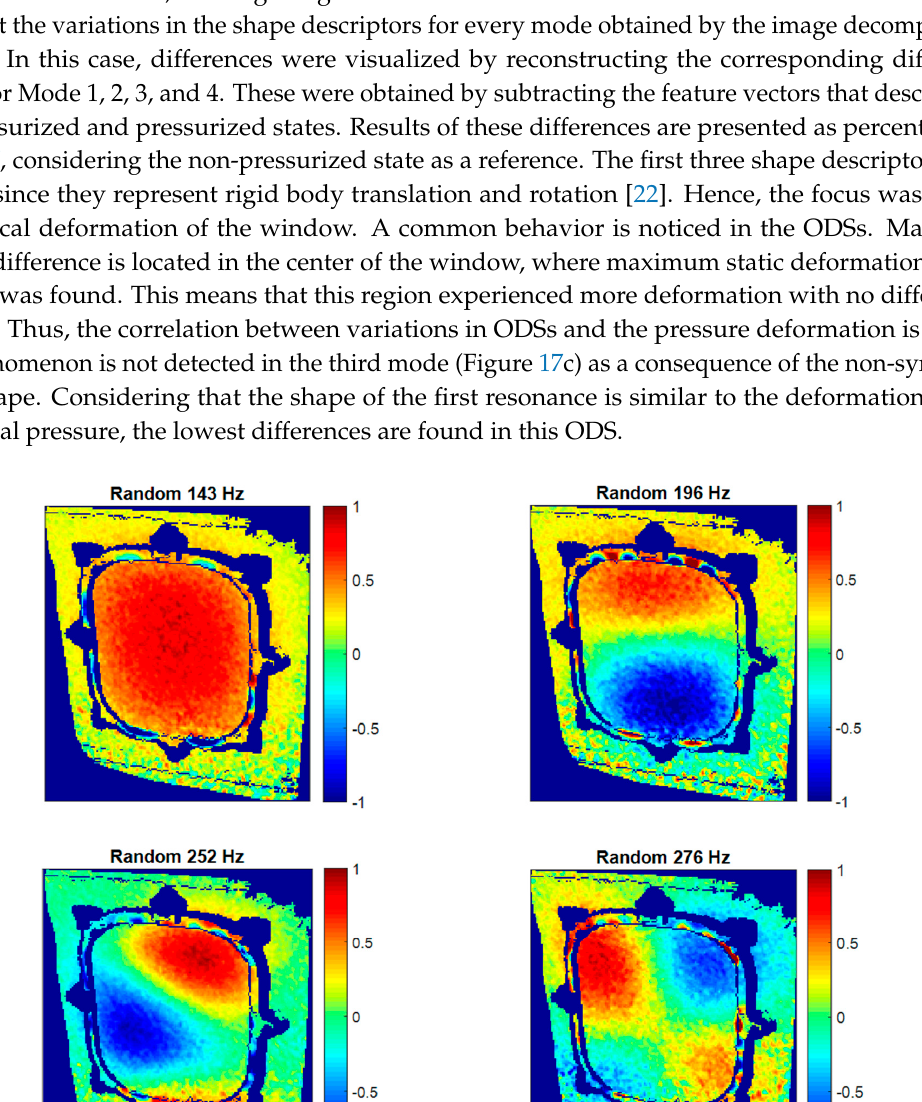
( d ) Figure 17. Reconstruction of the percentage differences between shape descriptors representing both ODSs in non-pressurized and pressurized states. ( a ) Mode 1; ( b ) Mode 2; ( c ) Mode 3; and ( d ) Mode 4.